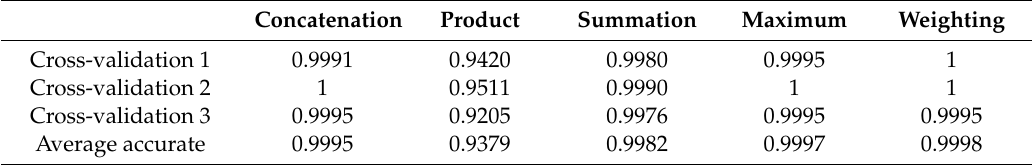
Table 12. The accuracy comparison of various feature fusion methods in the CIA dataset.